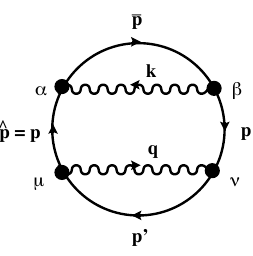
Figure 7 . Parametrization of diagram